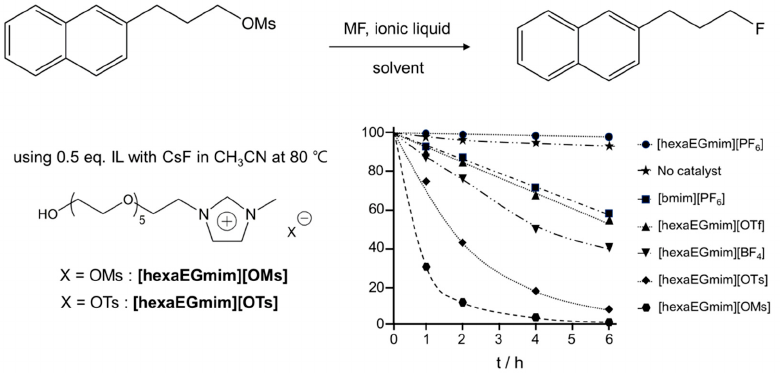
Figure 5. S N 2 fluorination [Cs + F − + C 3 H 7 OMs → C 3 H 7 F + Cs + OMs − ] in [hexaEGmim][X] ionic